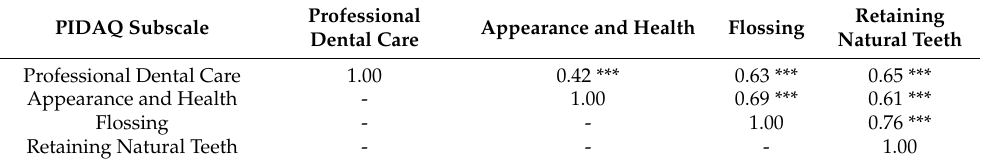
Table 4. Correlation between PIDAQ subscale